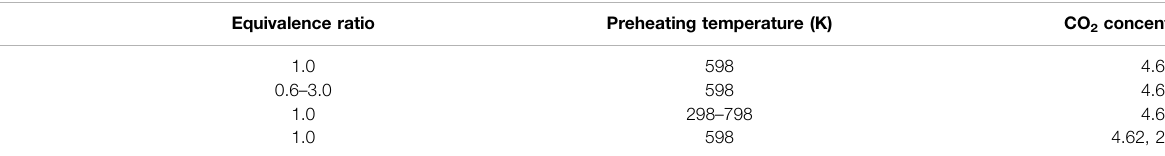
TABLE 3 | Simulation calculation condition setting.